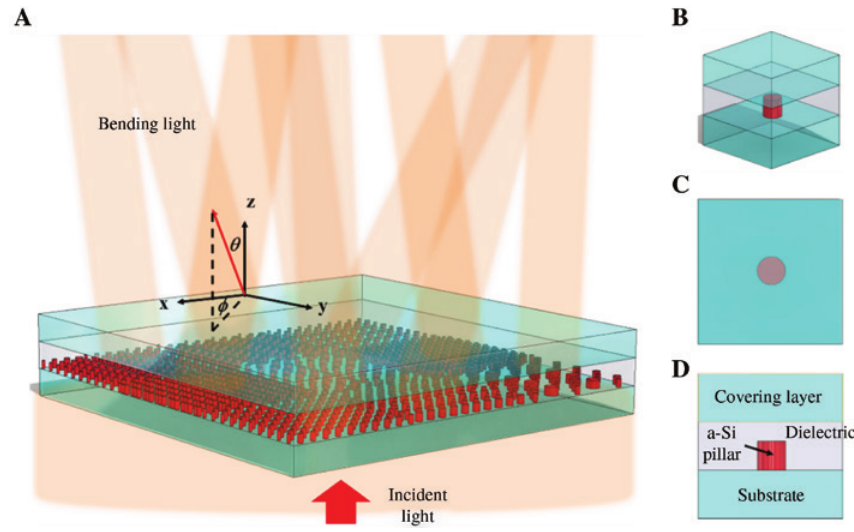
Figure 1: Schematic of the large-area pixelated metasurface beam deflector to generate random points. (A) Schematic of the pixelated metasurface beam deflector (drawing not to scale), demonstrating the concept for random point generator. (B) The perspective view, (C) top view and (D) side view of a one unit cell of the a-Si